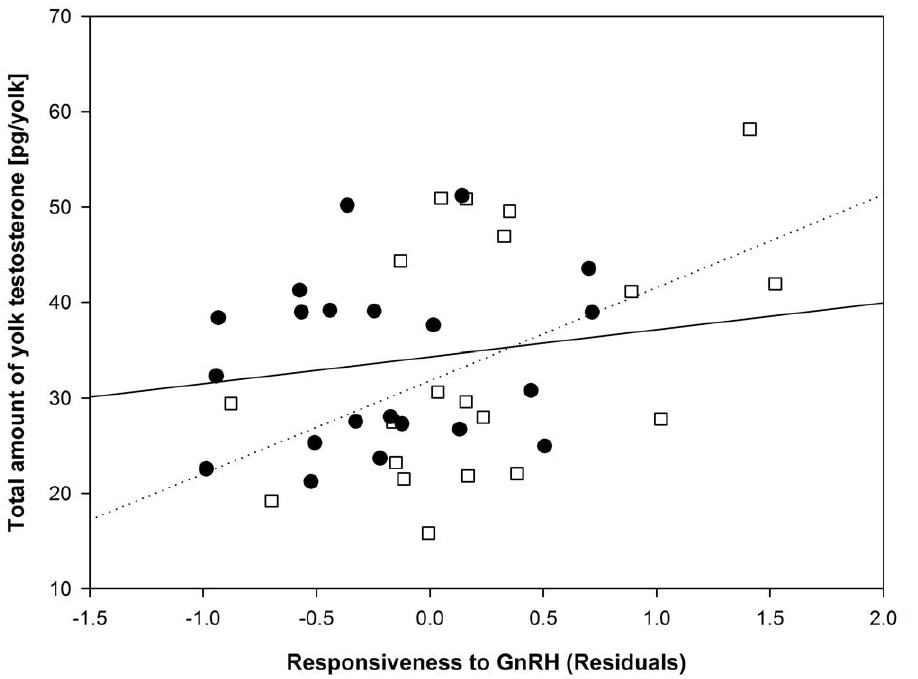
Figure 2. Relationship between testosterone response to a challenge with GnRH and yolk testosterone. Relationship between the increase in plasma testosterone concentrations 30 min after injection of GnRH and the amount of testosterone deposited in the yolk, using the residuals of the responsiveness to GnRH on the length of the time interval between injection of GnRH and laying of the first egg. Data are split for females hatched from control-treated eggs (C-females, open symbols and dotted line) and females hatched from testosterone treated eggs (T- females, filled symbols and solid line).